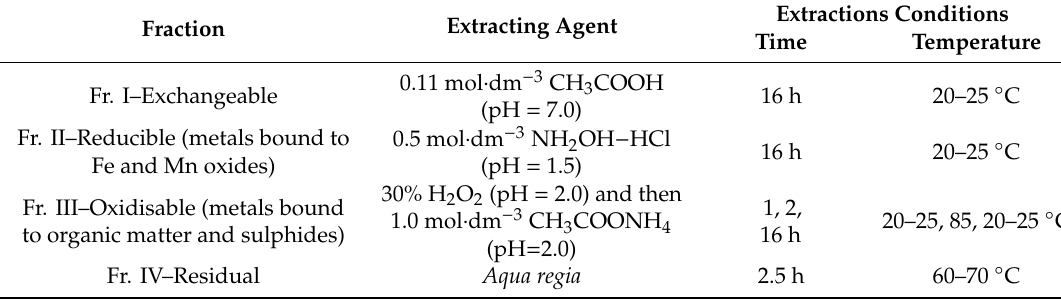
Table 2. Community Bureau of Reference (BCR) sequential extraction procedure